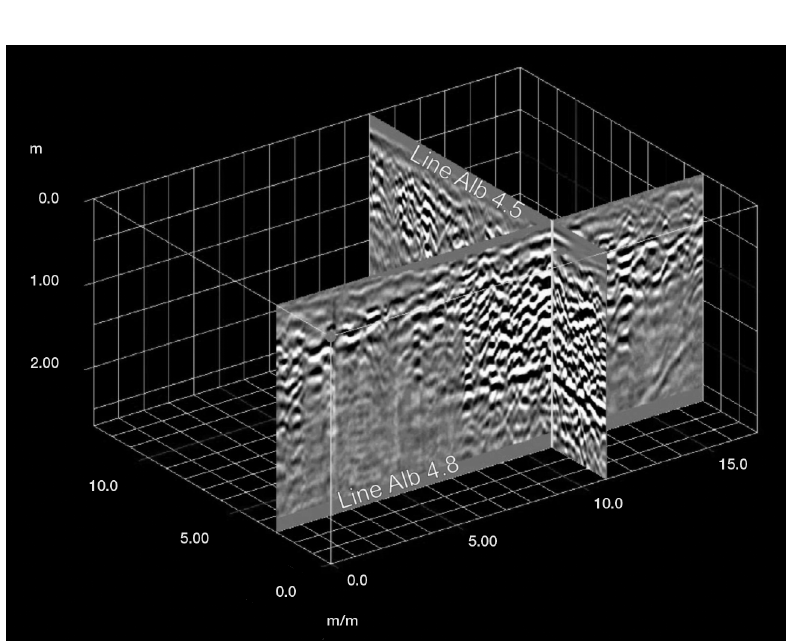
Fig. 5. Perpendicular GPR lines Alb 4.8 and Alb 4.5 plot showed the 2D continuity of anomaly due to the buried room.